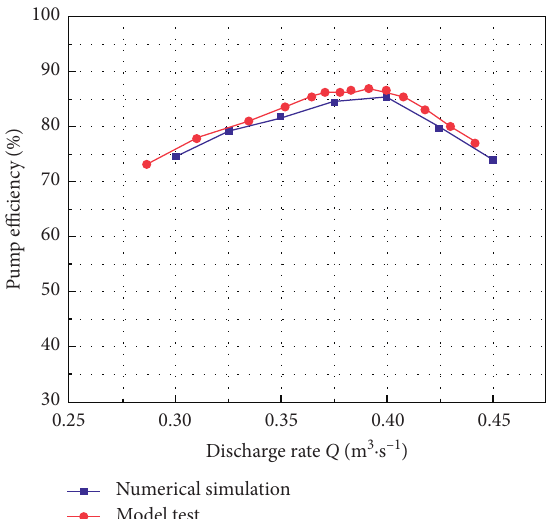
Figure 3: Comparison of the numerical simulation and model test results.